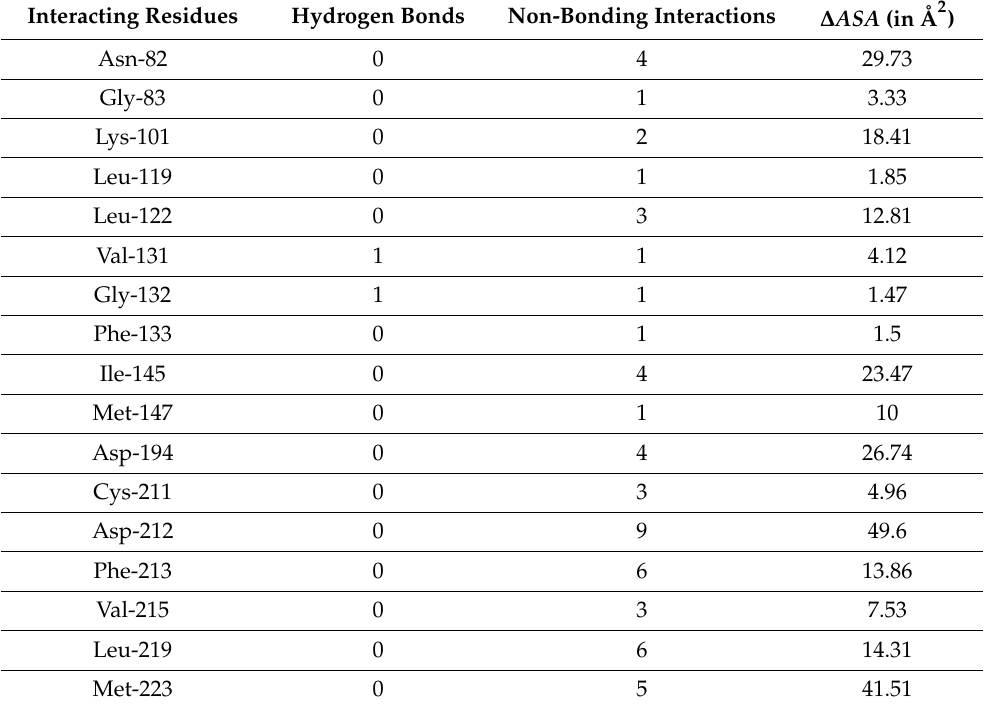
Table A7. The MEK2 residues interacting with selected flavonoid M2F7 are listed with the number of non-bonding interactions and ∆ ASA